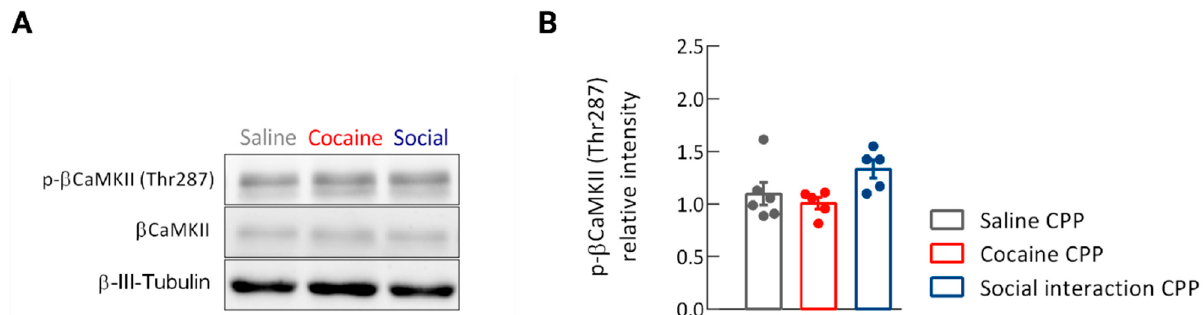
Figure A1. β CaMKII phosphorylation levels in the nucleus accumbens (NAc) after cocaine and social interaction CPP. ( A ) Representative western blot images of phosphorylated β -CaMKII (p- β CaMKII) (Thr287), β CaMKII, and β -III-Tubulin levels (used as protein loading control) in the NAc of rats from the saline, cocaine, and social interaction CPP groups. ( B ) Relative intensity of NAc β CaMKII phosphorylation at Thr287 in rats that expressed saline, cocaine, and social interaction CPP. p = ns; n = 5–6. Results are presented as mean ± SEM.